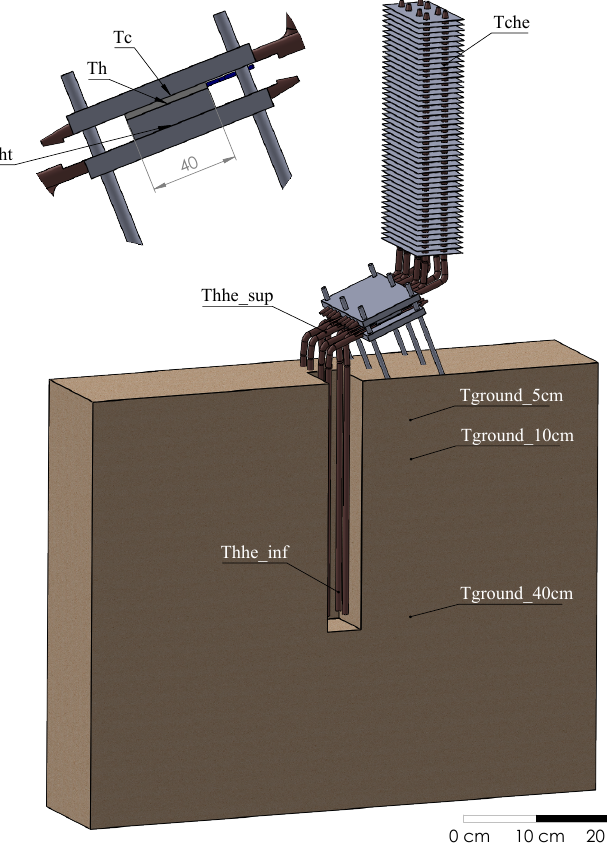
Figure 8. Positioning of the K-type